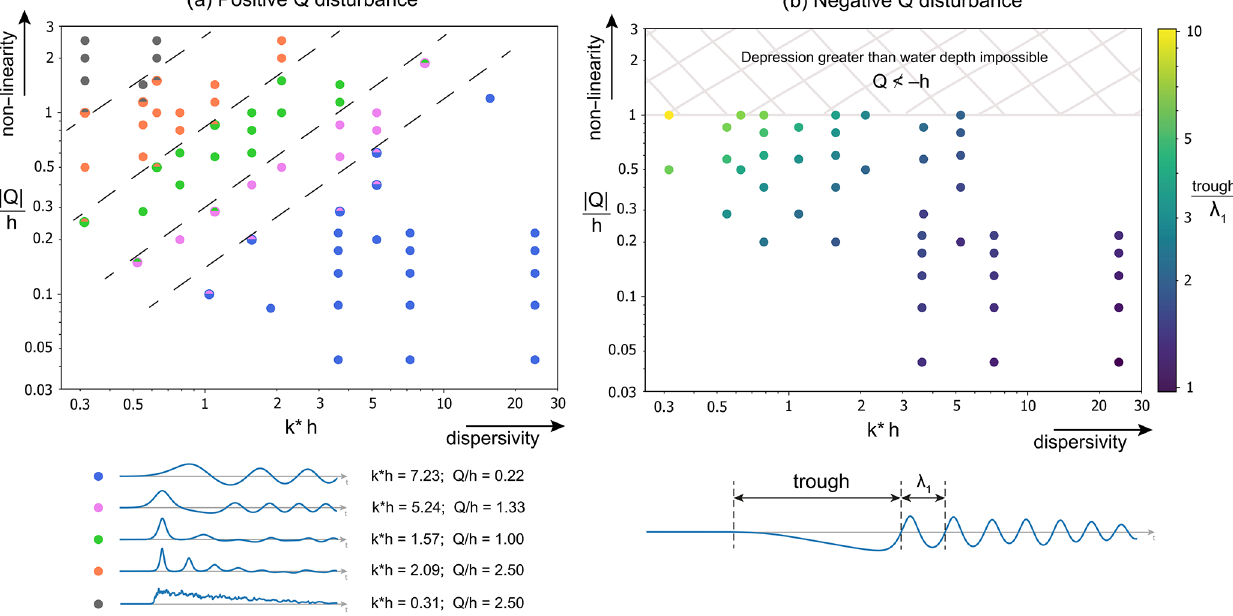
Figure 5. Plots of numerical runs by dispersivity parameter against non-linearity parameter. All data from time series are at x = 35ft. (a) Classification of + Q disturbances by their generated wave field. The legend underneath is illustrated by plots of example runs. (b) − Q disturbances coloured by the ratio of initial trough length divided by the following